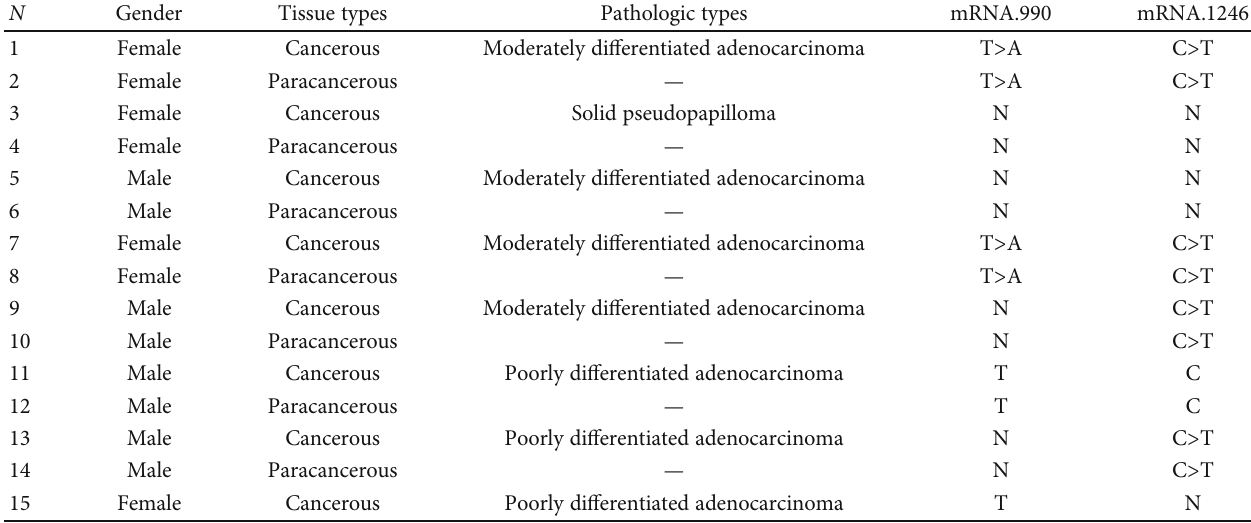
Table 2: Relationship between DDIT4 mutation and pancreatic